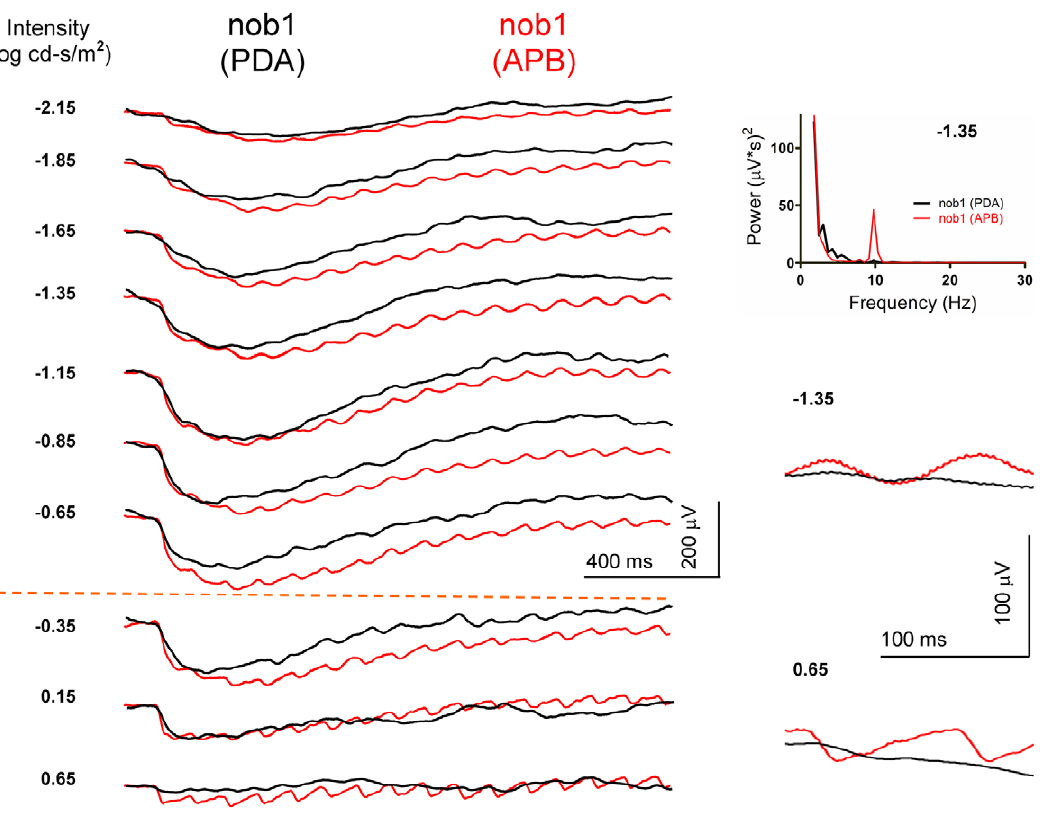
Figure 7. Effects of intravitreal injection of APB and PDA in a nob1 mouse. Both eyes show negative waveforms after injections. In the PDA- injected eye, the rod- and cone-driven flicker ERG OFF pathway responses are reduced. However these responses are resistant to APB. Frequency spectra indicated that the 10 Hz components in the PDA injected eye are very small.